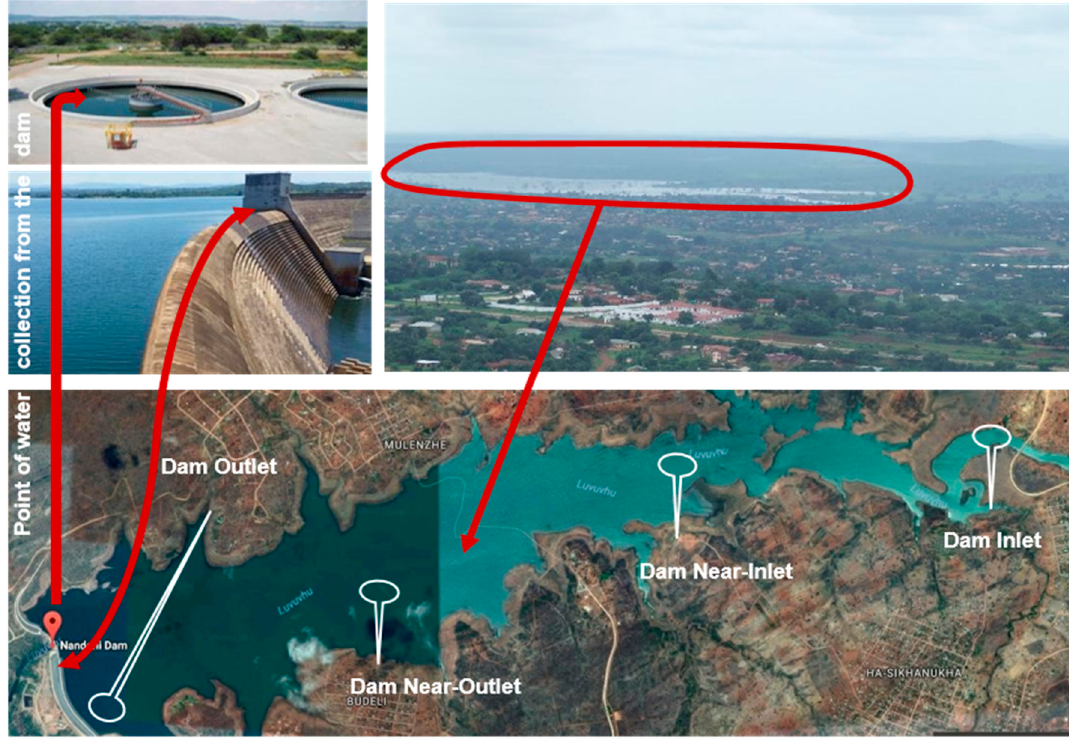
Figure 2. An overview of the sampling points located using Google Figure 2 . An overview of the sampling points located using Google Maps.